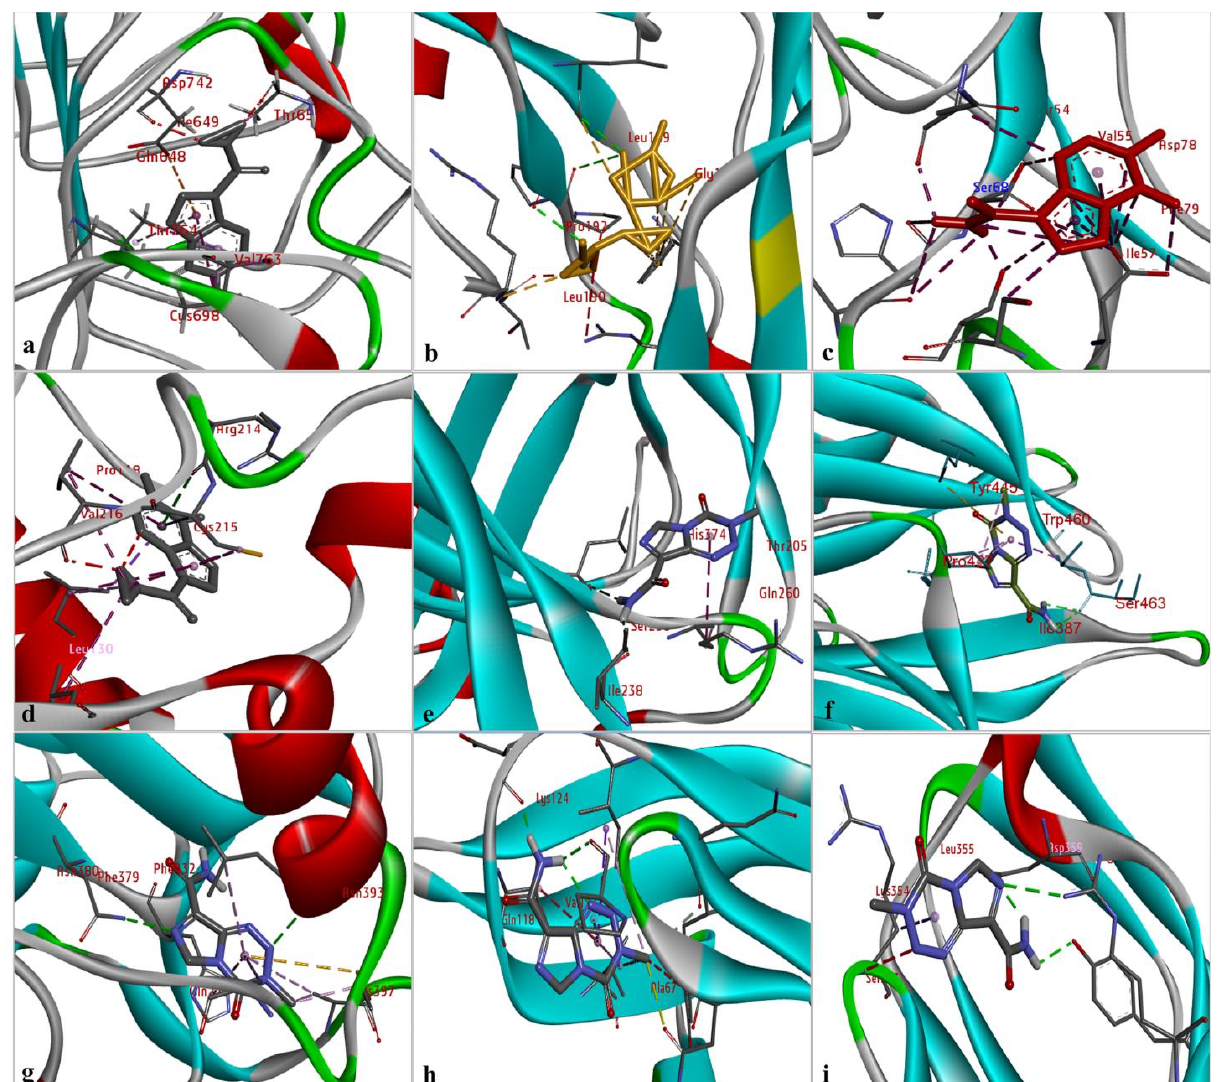
Figure 3. The identification of the peptide conformations of interacting residues of the selected proteins: ( a ) SLIT1; ( b ) GDF1; ( c ) LY6H; ( d ) CREG2; ( e ) SERPIN1; ( f ) LGI1; ( g ) NPTX1; ( h ) OPCML; and ( i ) CNTN2. Table 1. Docking interaction of TMZ with the target proteins.